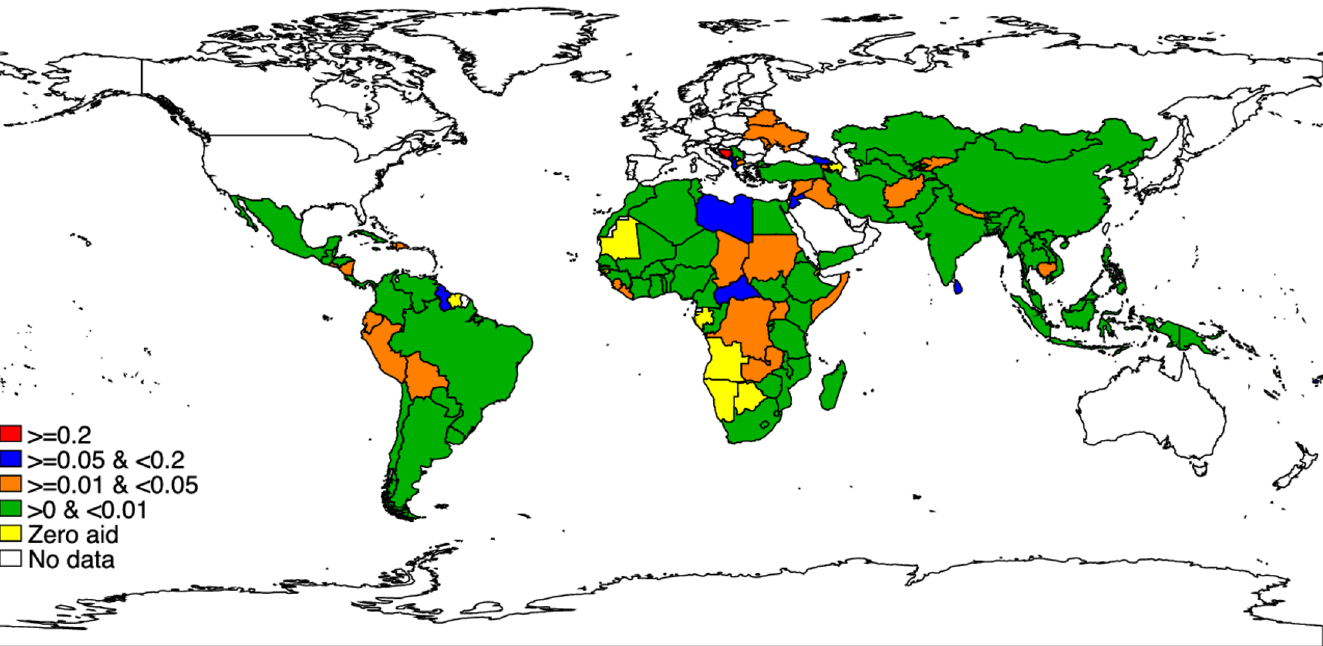
Fig 3. Average annual per capita DAMH_CA disbursement between 2007 and 2015 in each country (2013 USD), lower-bound estimates. (1) The top 10 countries with the highest average annual per capita DAMH_CA disbursement are West Bank and Gaza Strip (US$2.88), Kiribati (US$1.33), Lebanon (US$0.37), Bosnia and Herzegovina (US$0.23), Samoa (US$0.16), Georgia (US$0.15), Jordan (US$0.13), Sri Lanka (US$0.11), Libya (US$0.11), and Central African Republic (US$0.11). (2) We did not include unallocable or regional DAMH_CA projects. DAMH_CA, development assistance for child and adolescent mental health; USD, US dollar.